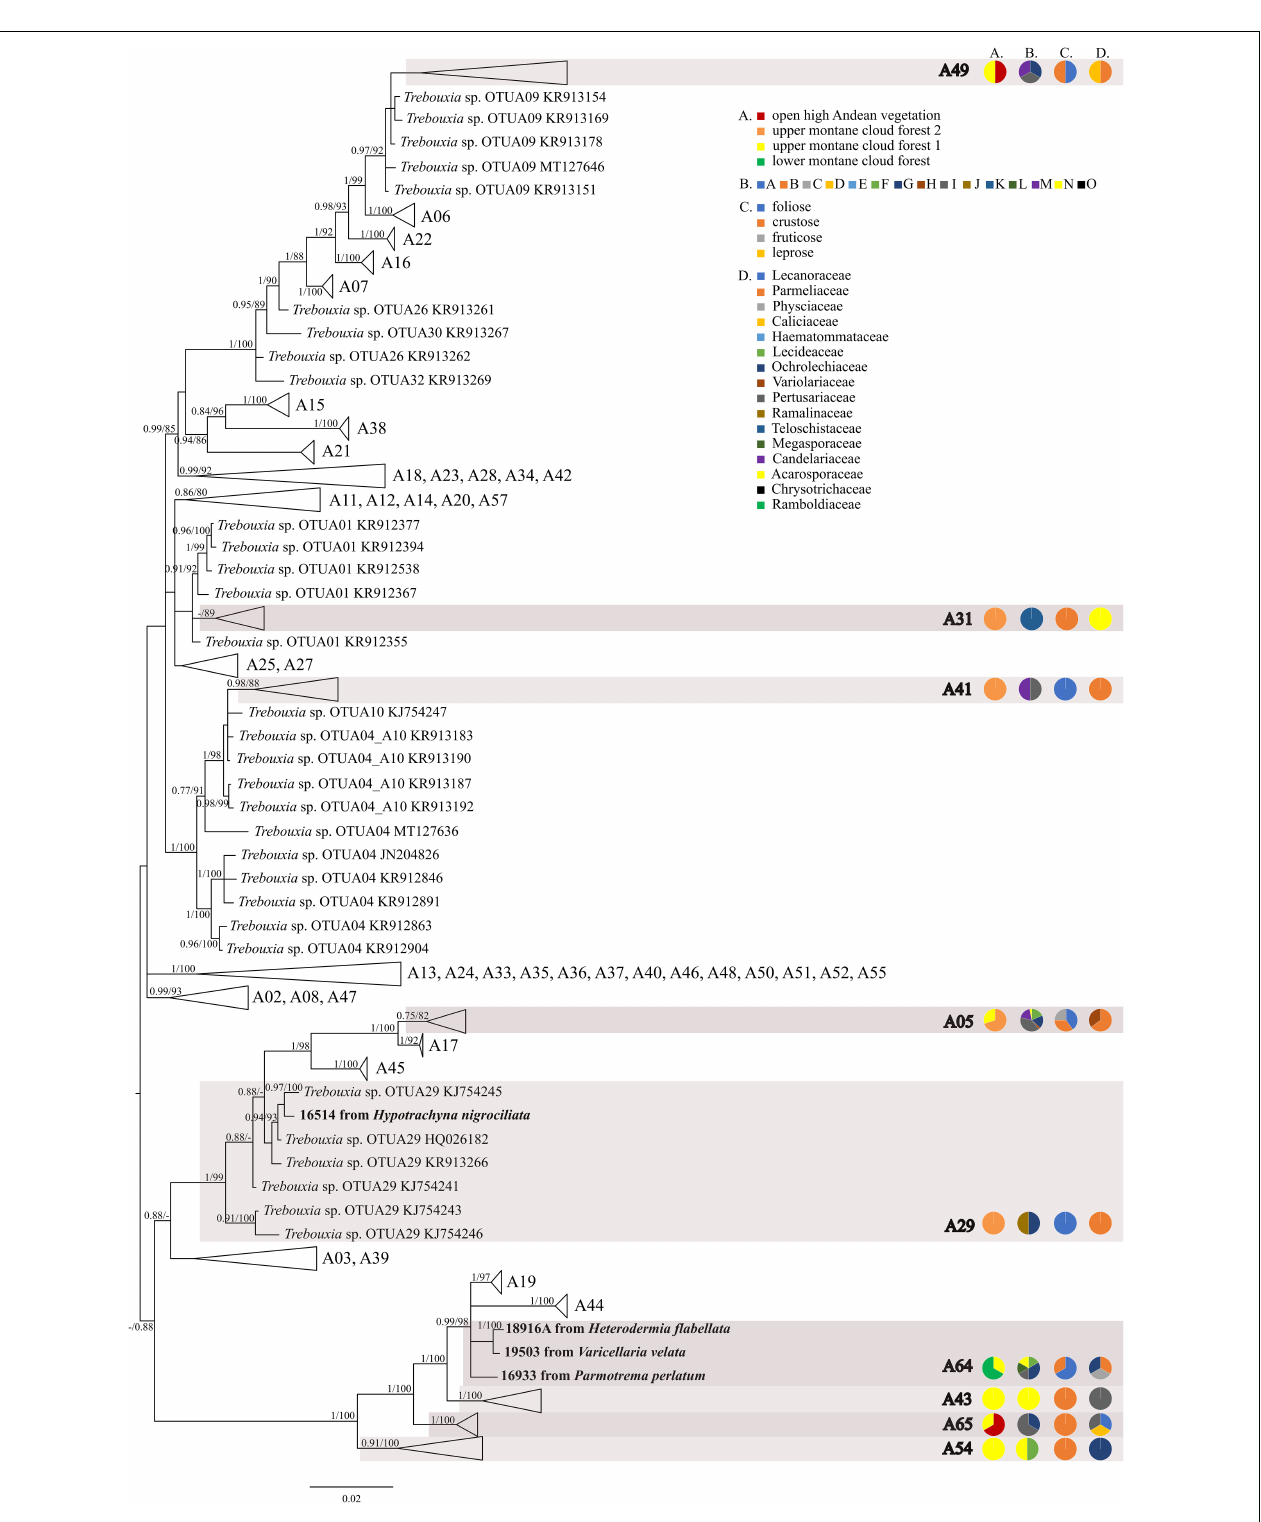
FIGURE 1 | Collapsed majority-rule consensus tree from Bayesian analysis of Trebouxia clade A based on ITS rDNA, rbc L and cox2 locus dataset with posterior probabilities and bootstrap support values from IQ-TREE analysis presented near the branches. For each record from GenBank, accession no. with photobiont name are given (following Moya et al., 2017; Molins et al., 2018; Muggia et al., 2020). For newly sequenced samples, voucher no. and their mycobiont host